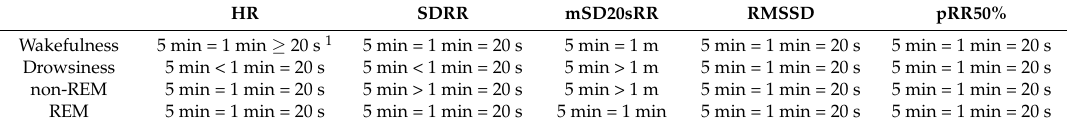
Table 3. Summary of results comparing the different sampling intervals from the first occurrence of all sleep stages. The direction of significant differences are indicated with inequality signs (>, <). Results that deviate from the analysis based on the longest occurrence of the sleep stages are marked with italics.